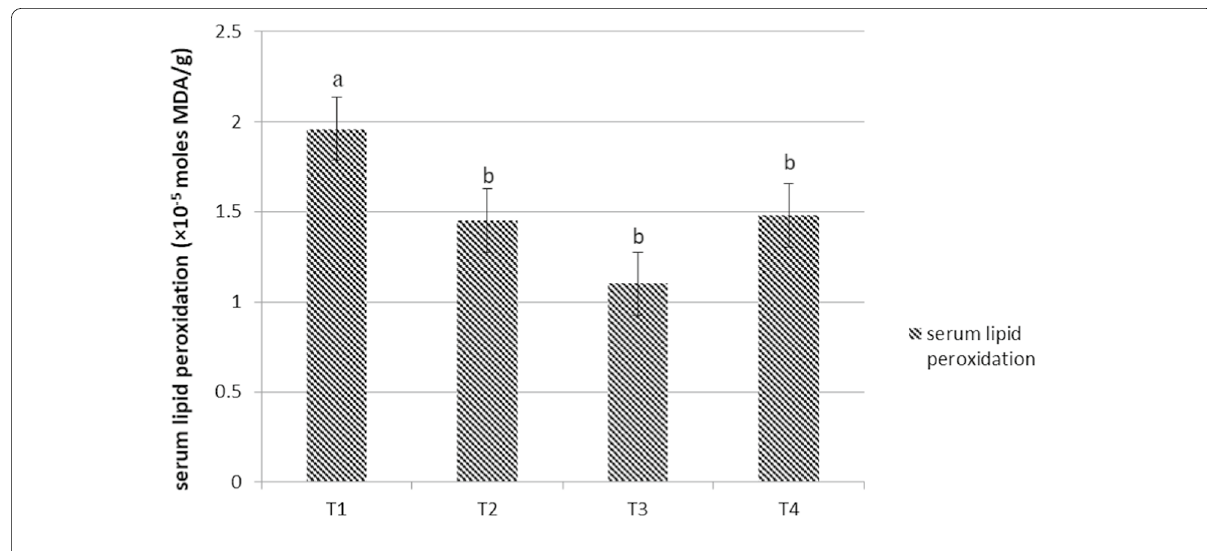
bicarbonate. Fig. 3 Serum lipid peroxidation profile of rabbit bucks administered ascorbic acid and sodium bicarbonate. T1-control, T2- ascorbic acid, T3-sodium bicarbonate, T4-ascorbic acid sodium +